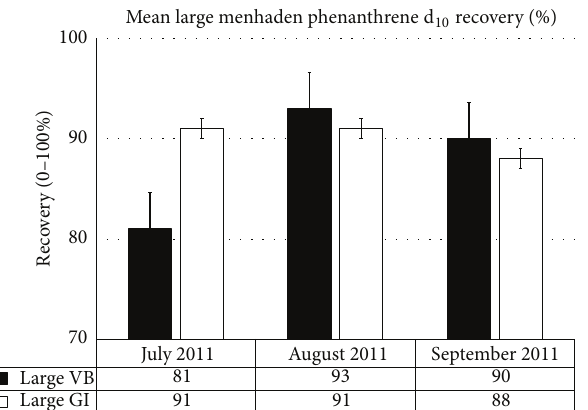
Figure 3: Mean “small” menhaden phenanthrene d 10 recoveries based on site and month, Summer 2011 (recoveries by month were not significantly different 𝛼 = 0.05 ).